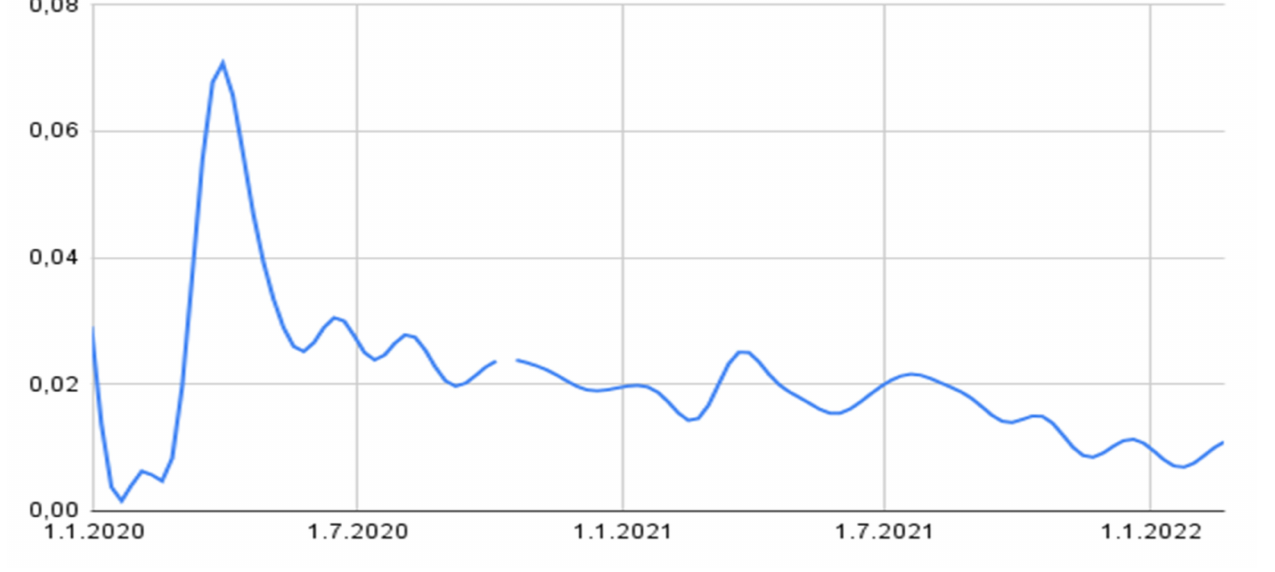
Figure 10. The graph of normalized publication activity for the topic “Case, Infection, Coronavirus, Coronavirus_Infection, Coronavirus,